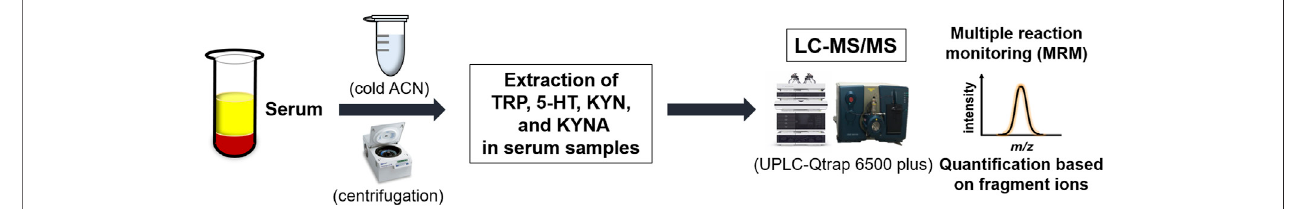
FIGURE1| Work fl owofanalysisofkynureninepathwaymetabolitesinserumsamplesusingliquidchromatographycoupled withtandemmassspectrometry (LC- MS/MS). ACN, Acetonitrile; TRP, Tryptophan; 5-HT, 5-hydroxytryptamine; KYN, Kynurenine; KYNA, Kynurenic acid.